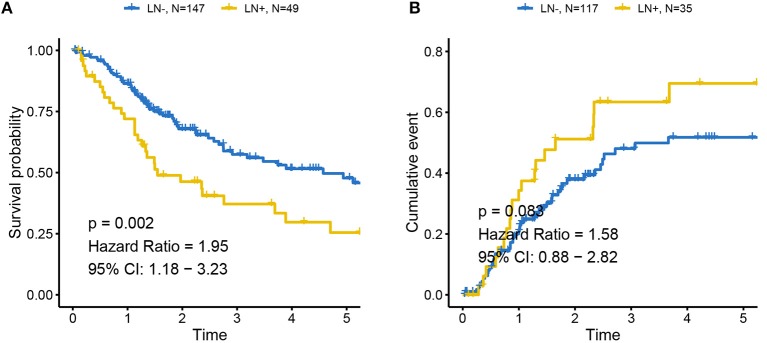
Association between LN metastasis status and patients' outcomes in TCGA cohort (A) for overall survival and (B) for progression-free survival. Tumors with LN+ demonstrated poor prognosis compared to LN– and a tendency could be observed where LN+ tumors presented higher recurrence rates. LN– was regarded as the reference for the calculation of HR.